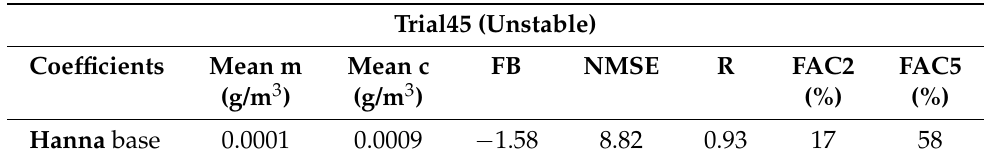
Table 4. 45. m indicates measured and c calculated.